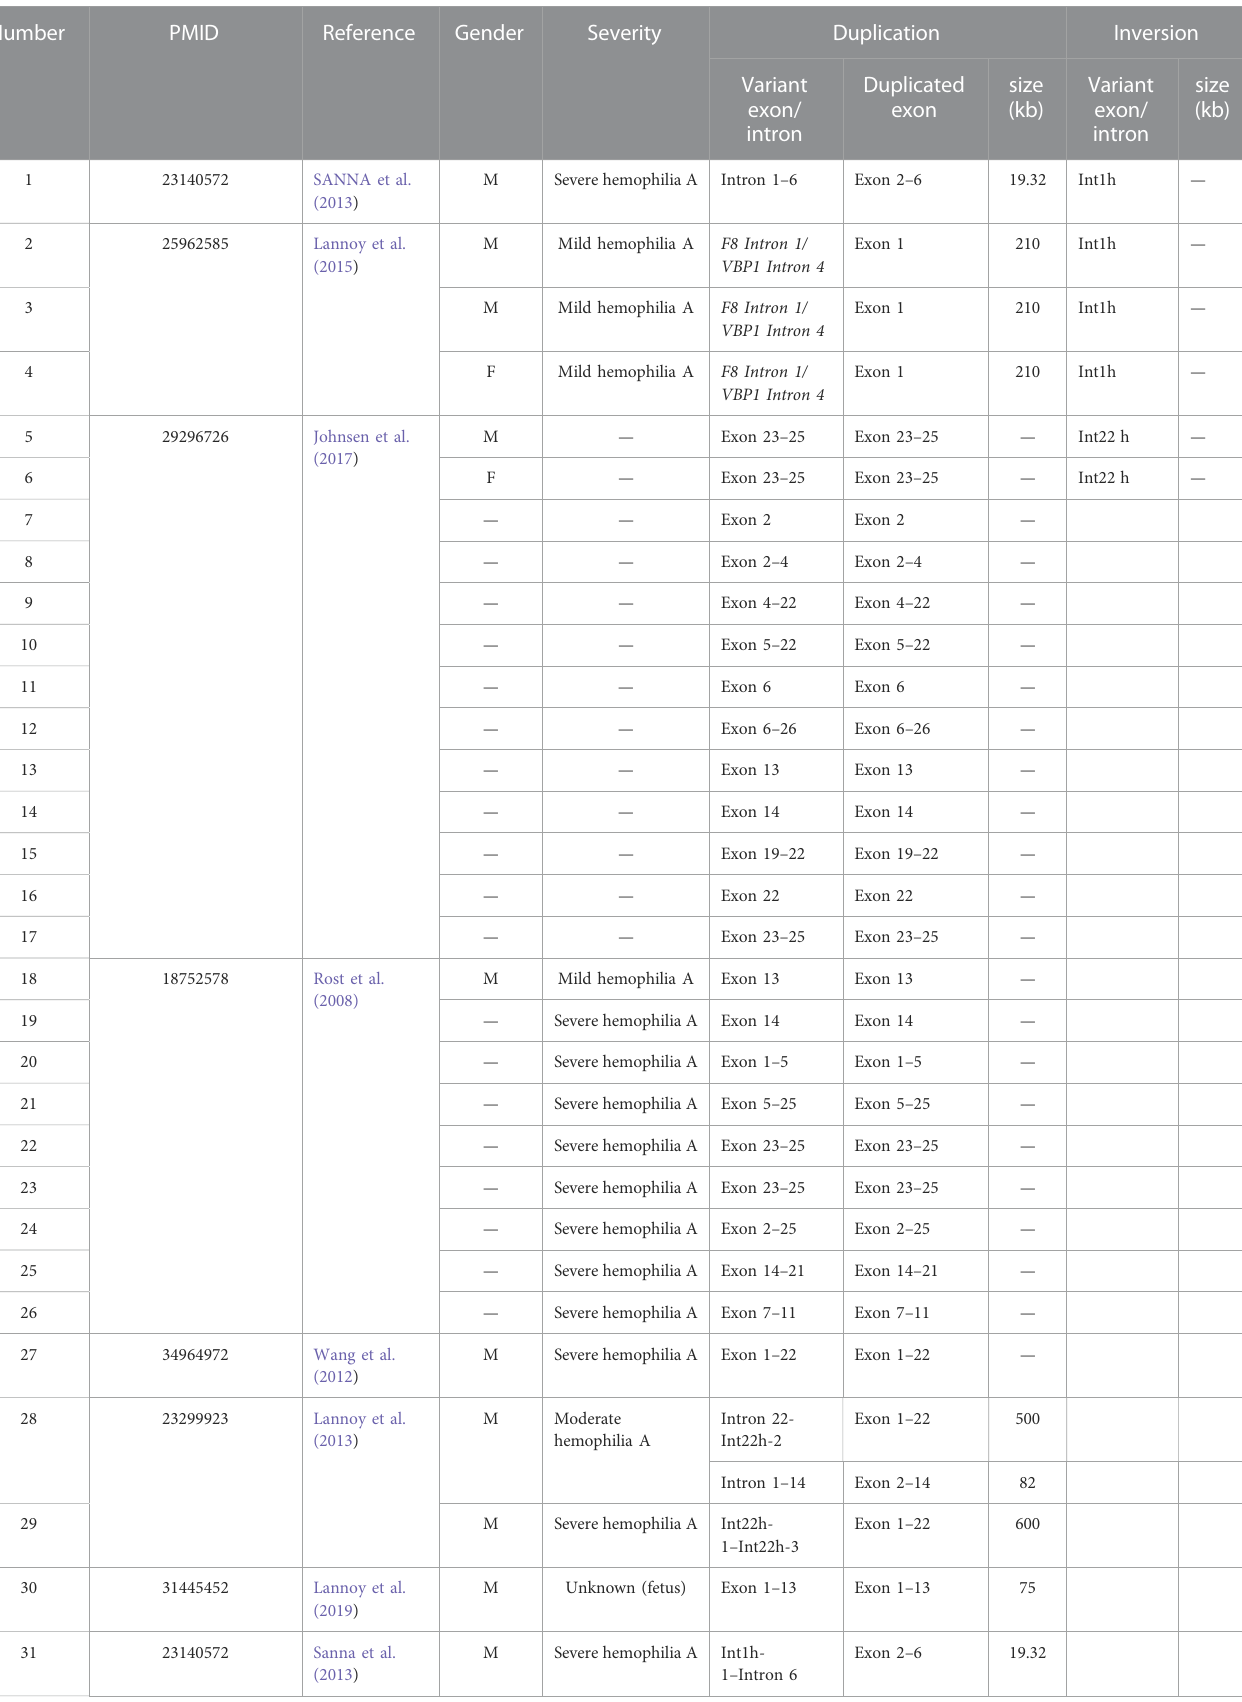
TABLE 1 Fifty-two HA patients with large duplications of F8 . Number